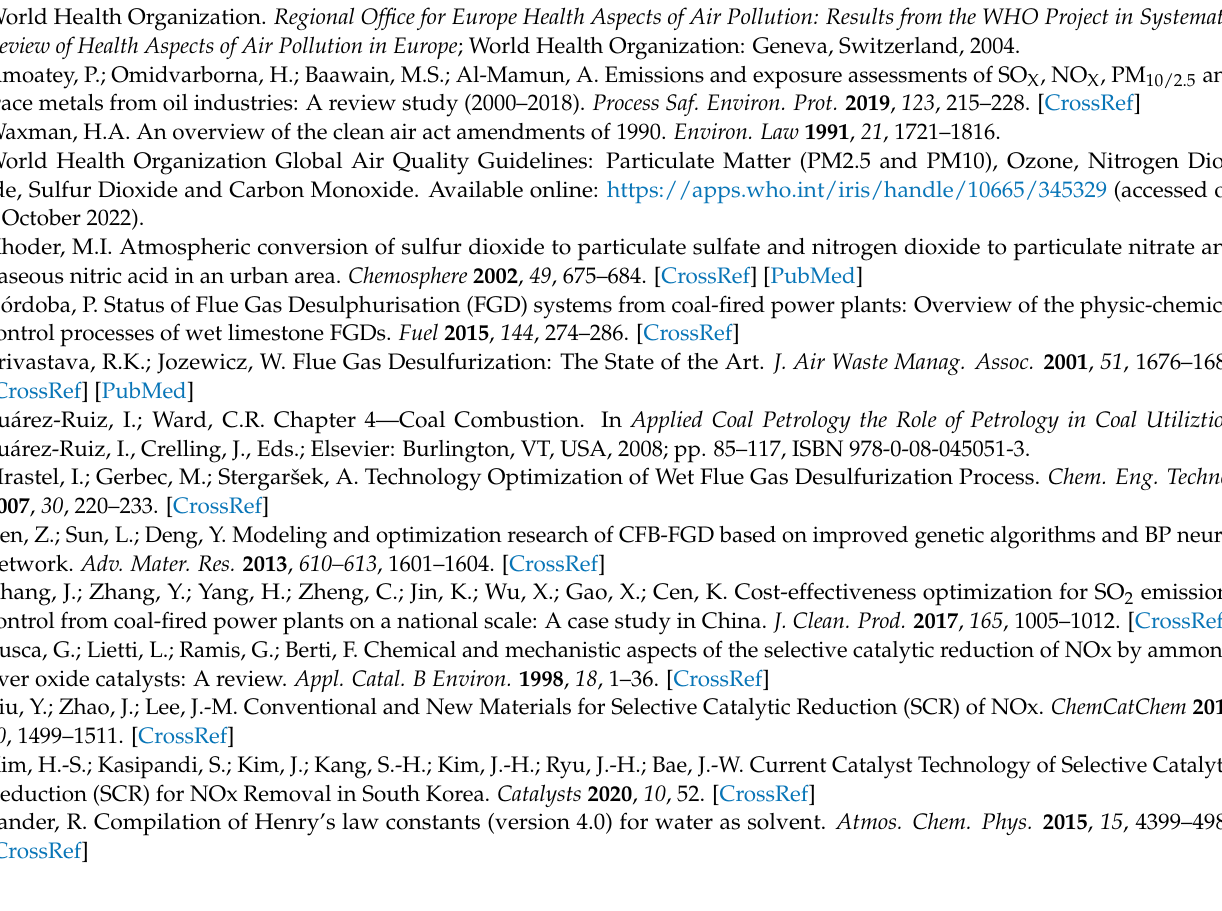
SiO 2 /Co(OH) 2 synthesized at 25 ◦ C; Figure S8: Powder XRD pattern of SiO 2 /Co(OH) 2 synthesized at 95 ◦ C; Figure S9: Effect of silica concentration on catalyst activity (SiO 2 /Co(OH) 2 ; [Co] = 6 mM); Figure S10: Effect of cobalt concentration on catalyst activity (SiO 2 /Co(OH) 2 ; [SiO 2 ] = 1